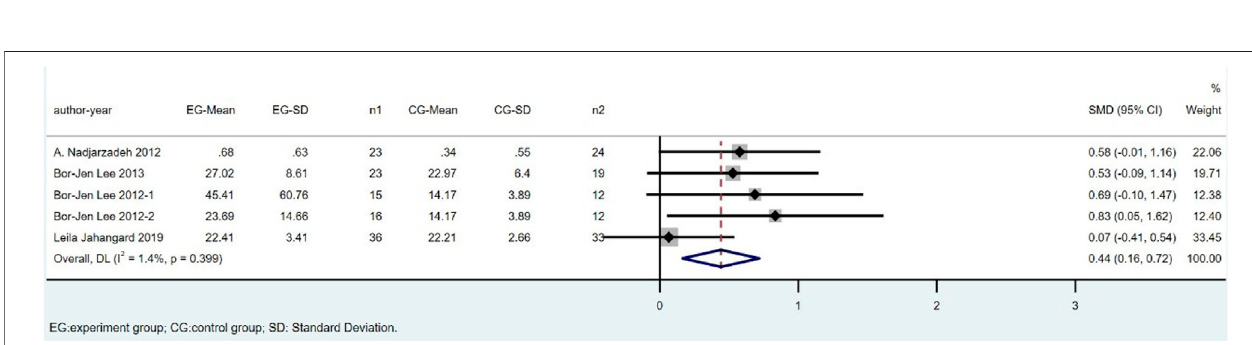
FIGURE 7 | Meta-analysis of studies investigating the effect of CoQ10 supplements use on CAT